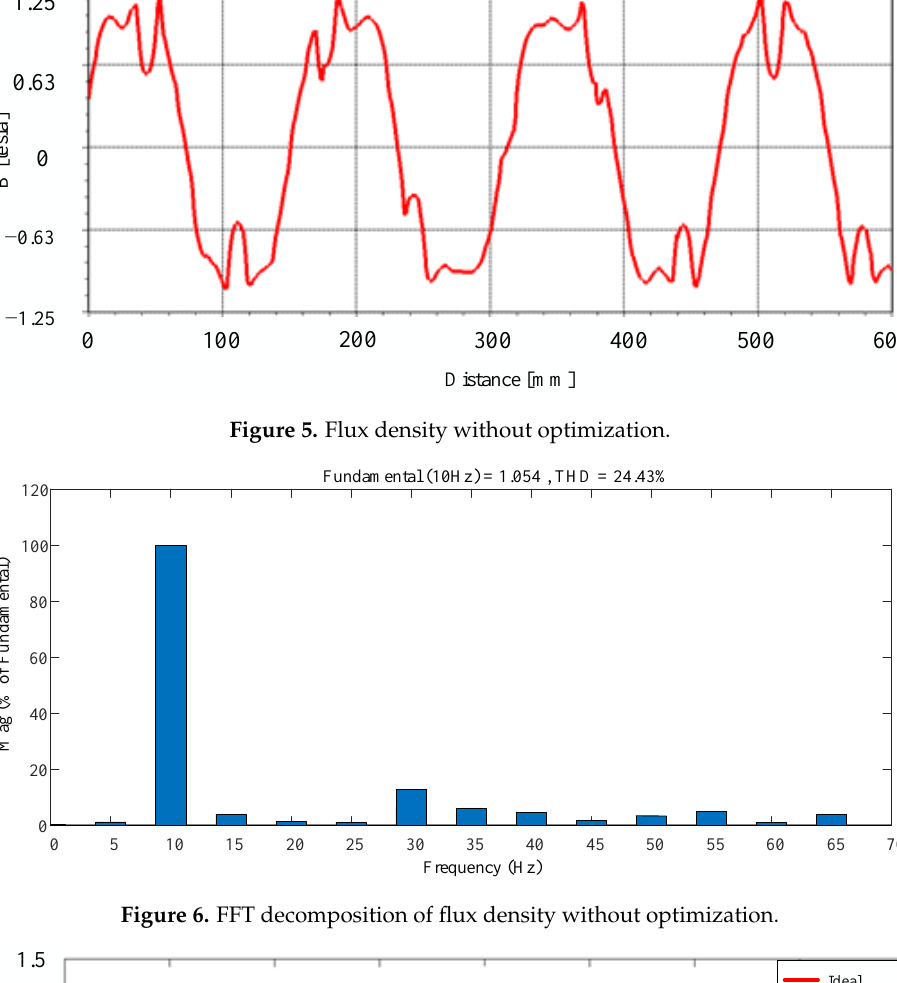
Figure 4. Evolution results of permanent magnets.